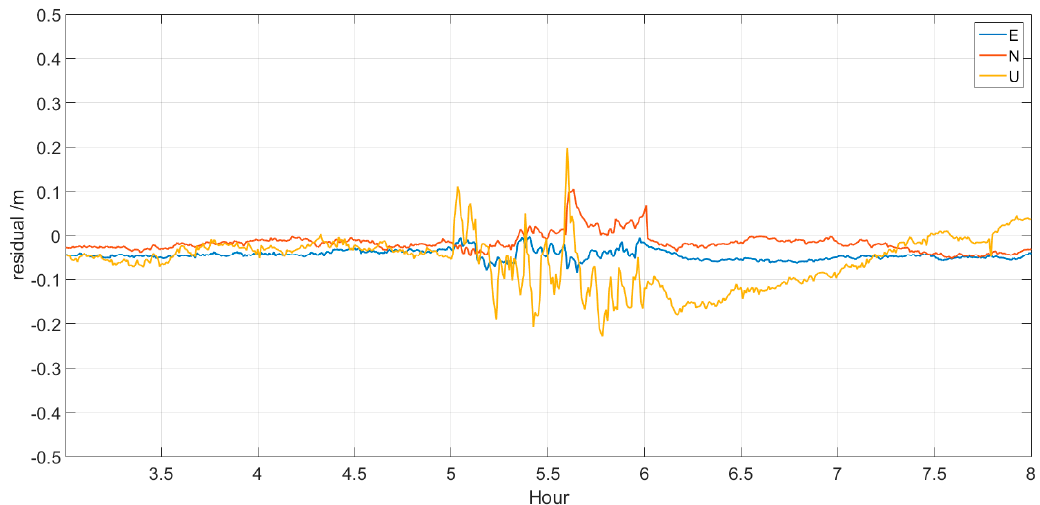
Figure 10. Residuals of kinematic PPP for CEDU. Table 6. Statistics of the kinematic PPP during the prediction period (1-h).